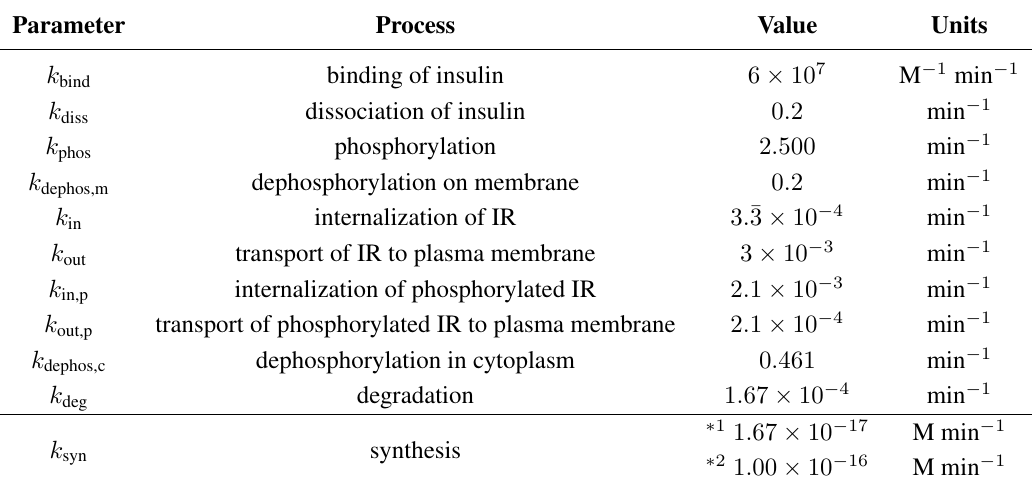
Table 2. List of kinetic parameters of the reaction system (5). The kinetic parameters are adopted from Sedaghat et al. [34]. For the rates of degradation and synthesis of the IR in the cytoplasm, we chose the values of Quon and Campfield